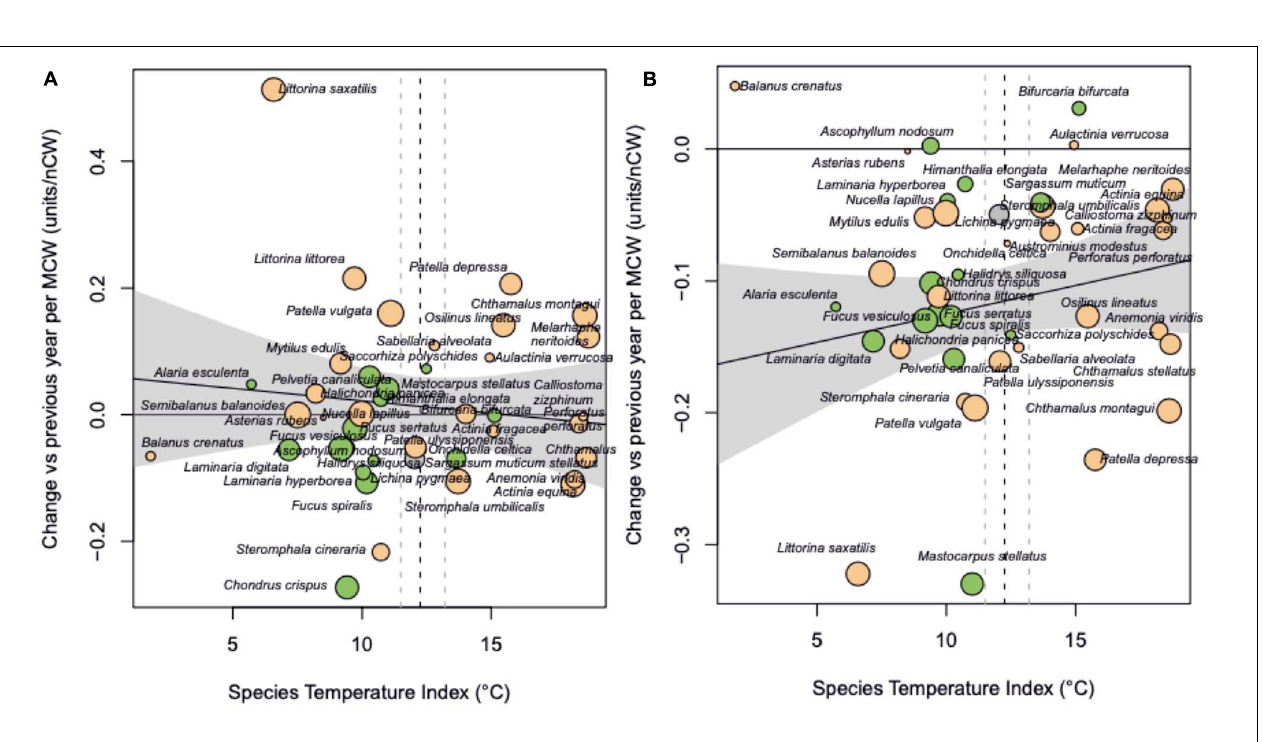
FIGURE 5 | (A) Response to summer cold spells and (B) response to winter cold spells. Regression slopes for (A) Y = 0.049 ( ± 0.076 SE) – 0.0024.STI ( ± 0.0061 SE), p = 0.70; (B) Y = –0.160 ( ± 0.043 SE) + 0.0047.STI ( ± 0.0021 SE), p = 0.33. Regression intercept for (B) was significantly negative ( p = 0.0005).